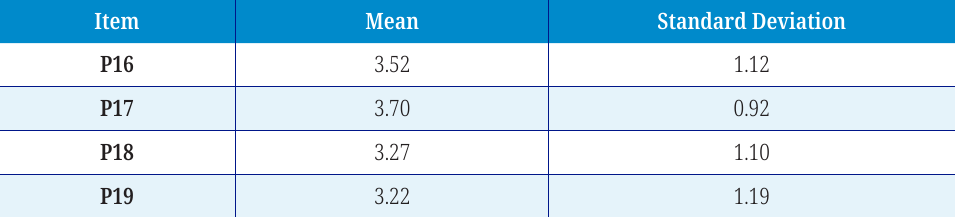
Table 7. Mean obtained by dimension 4